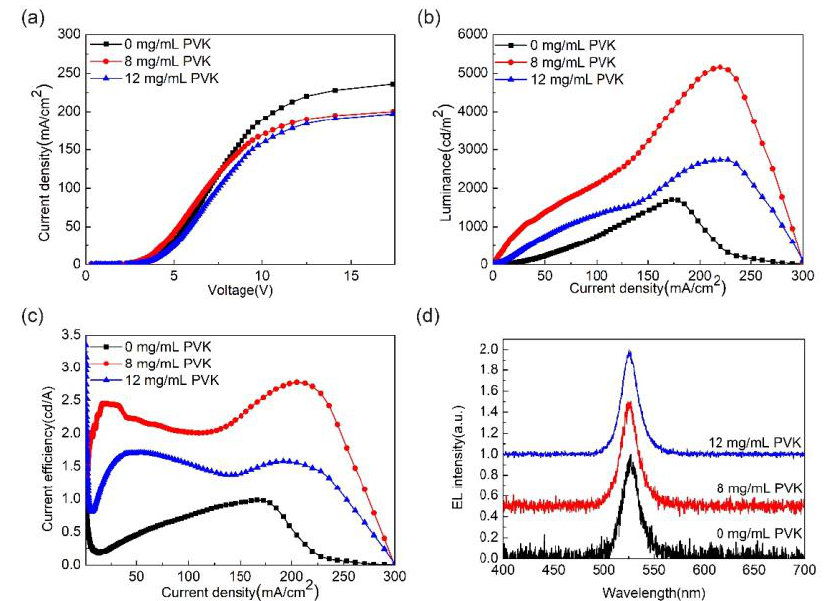
Figure 7. Photoelectric properties of PeLEDs using PEDOT:PSS/PVK bilayer hole transport layer ( a ) current density-voltage curve, ( b ) luminance-current density curve, ( c ) current efficiency-current density curve, and ( d ) electroluminescence spectra. Table 2. Summary of the device parameters of PeLEDs with different concentrations of PVK.